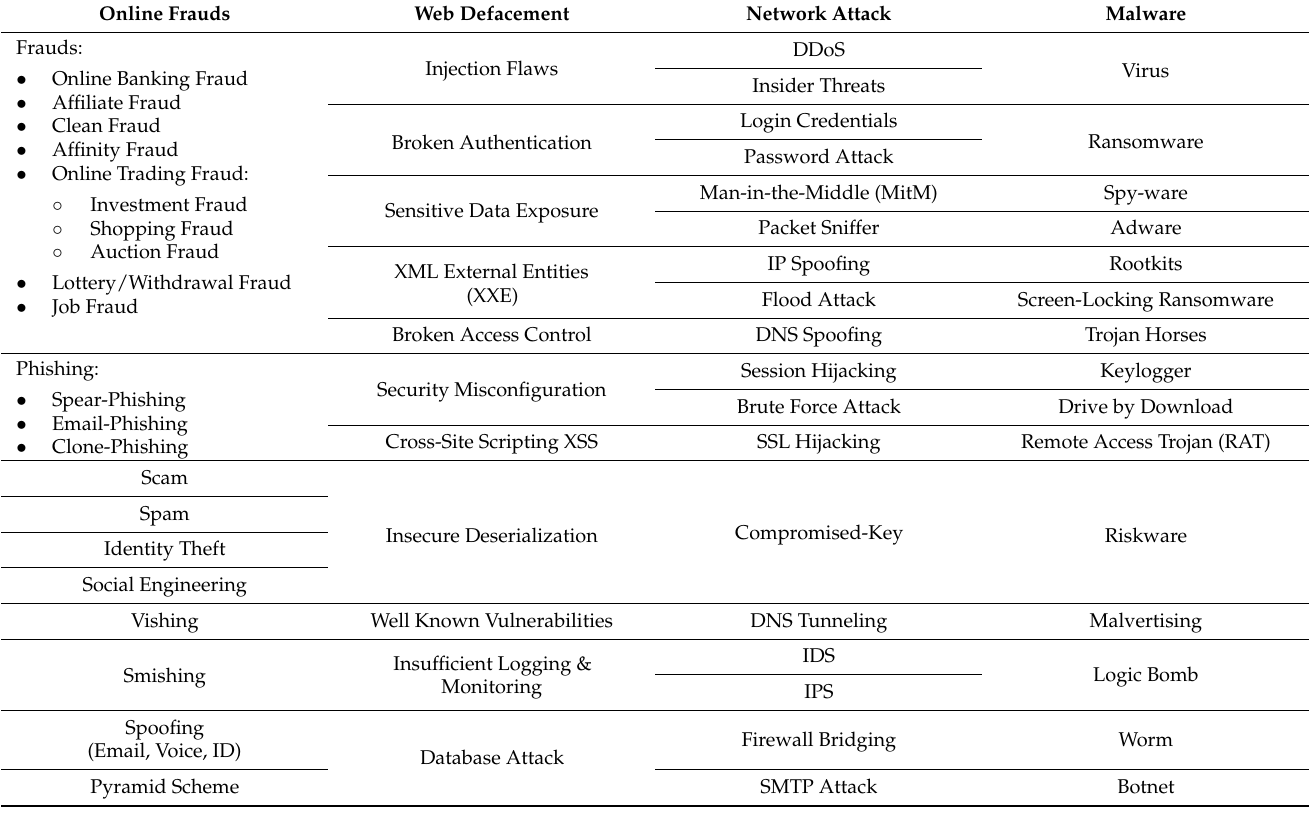
Table 2. The proposed cyber-security attack categories